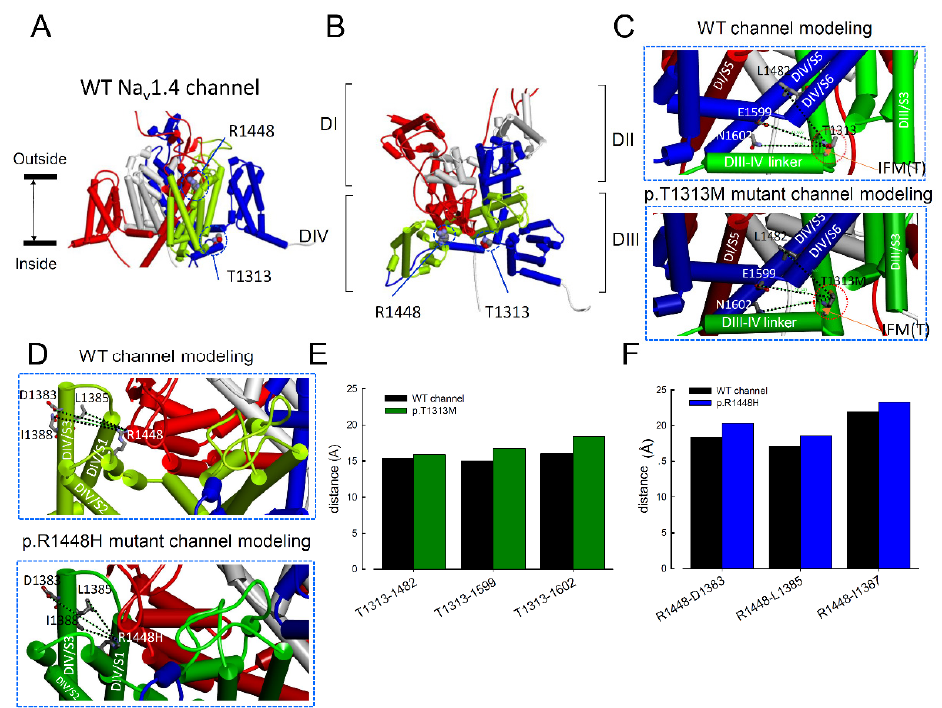
Figure 8. Homology Modeling of the Human WT and Mutant Na v 1.4 Channels. ( A ) The homology model was constructed based on the correlative X-ray crystal structures of Na v 1.4 using Discovery Studio 2018 [18–20]. Four subunits of WT Na v 1.4 homology modeling were shown. The side view of the homology model of the WT Na v 1.4 channel shows the transmembrane α -helix of the four domains. Domains I, II, III, and IV are colored red, white, blue, and green, respectively. The side chain of T1313M in the domain III–IV linker is indicated in the CPK model. The side chain of R1448H is located in the S4 of domain IV. ( B ) Regional view of the extracellular side of the pore in the homology model of the WT Na v 1.4 channel. ( C ) A diagram of two domains (DIII and DIV) in the homology models of WT and p.T1313M mutant Na v 1.4 channels. The side chains of p.T1313 to the p.L1482, p.F1599, and p.N1602 are indicated with sticks of different colors. The enlarged view of the boxed portion shows the inter-residue distances of ~15.3 Å, ~14.9 Å, and ~15.9 Å for p.T1313 to p.L1482, p.T1313 to p.F1599, and p.T1313 to p.N1602 in the WT channel, respectively. In the p.T1313M mutant channel, the distances were ~15.9 Å, ~16.7 Å, and ~18.4 Å, respectively. Arrowhead to identified the appropriate position of IMF. ( D ) Diagram of two domains from the homology models of the WT and p.R1448H Na v 1.4 channels. The side chains of p.R1448 to the residues p.D1383, p.L1385, and p.I1387 are indicated with sticks of different colors. In the WT Na v 1.4 channel, the inter-residue distances were ~18.32 Å, ~17.02 Å, and ~21.91 Å for p.R1448 to p.D1383, p.R1448 to p.E1385, and p.R1488 to p.N1602, respectively. In the p.R1488H mutant channel, they were ~20.32 Å, ~18.54 Å, and ~22.25 Å, respectively. ( E ) Summary plot to show the relative inter-residual distances (from tip-to-tip of the side chain) of p.T1313 (or p.T1313M) to L1482, p.T1313 to p.F1599, and p.T1313 to p.N1602 in the homology model. Distances between residues were increased in the p.T1313M mutant channel than in the WT Na v 1.4 channels. ( F ) Summary plot of the relative distances (from tip-to-tip of the side chain) of residues p.R1448 (or p.R1448H) to p.D1383, to p.L1385, and to p.I1387 in the homology model. Increased distances between residues were observed in the p.R1448H mutant channel than in the WT Na v 1.4